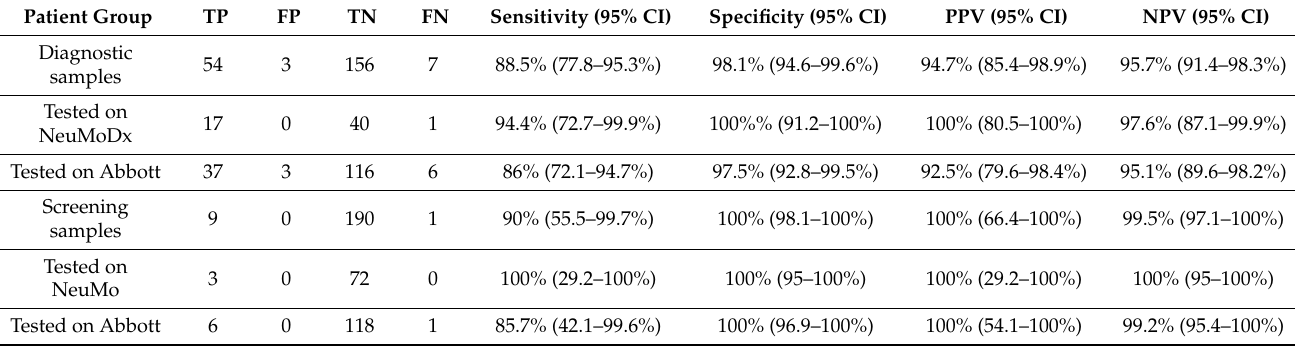
Table 2. Diagnostic performance of Fluidigm across patient groups.